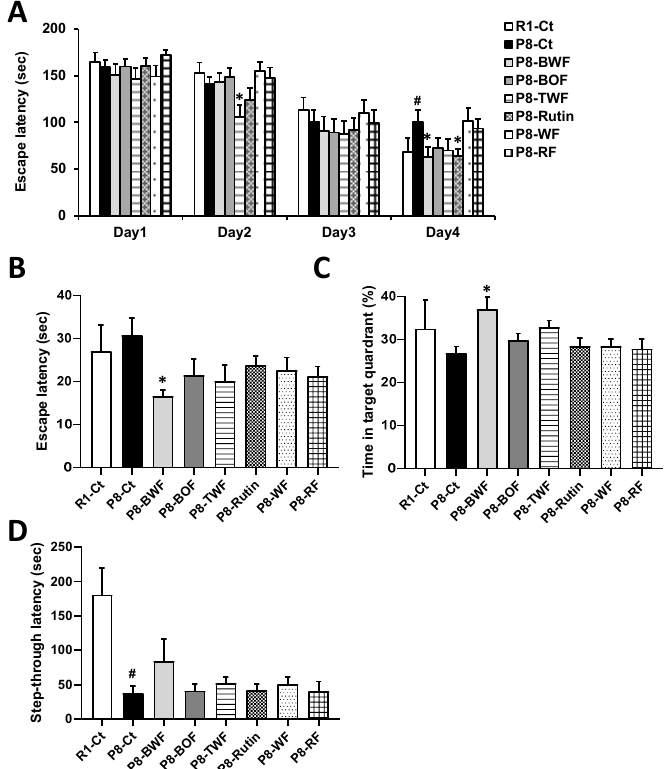
Figure 1. Effect of oral administration of various flours on learning and memory in SAMP8 mice. ( A ) Escape latency during training in the Barnes maze. ( B ) Escape latency during the probe test in the Barnes maze. ( C ) Time spent in target quadrant during the probe test in the Barnes maze. ( D ) Step-through latency in the passive avoidance test. Data are presented as the mean ± standard error of the mean ( n = 8 − 10). # p < 0.05, compared with SAMR1 control (R1-Ct) group. * p < 0.05, compared with SAM8 control (P8-Ct) group. SAMP8, senescence-accelerated mouse prone 8; SAMR1, senescence-accelerated mouse resistant prone 1; BWF, buckwheat whole flour; BOF, buckwheat outer flour; TWF, Tartary buckwheat whole flour; WF, wheat flour; RF, rice flour.